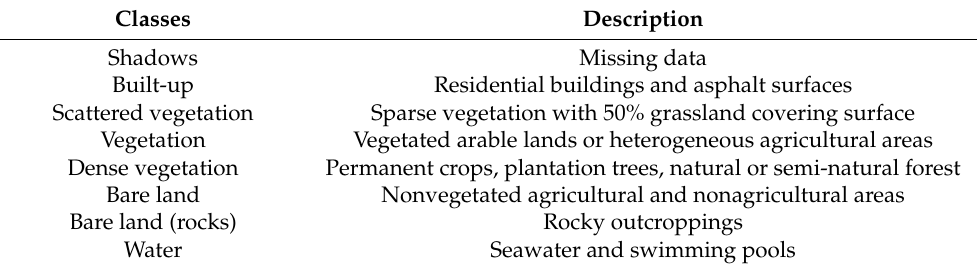
Table 3. Description of classes used for anthropogenic activity mapping on PBs of the province of